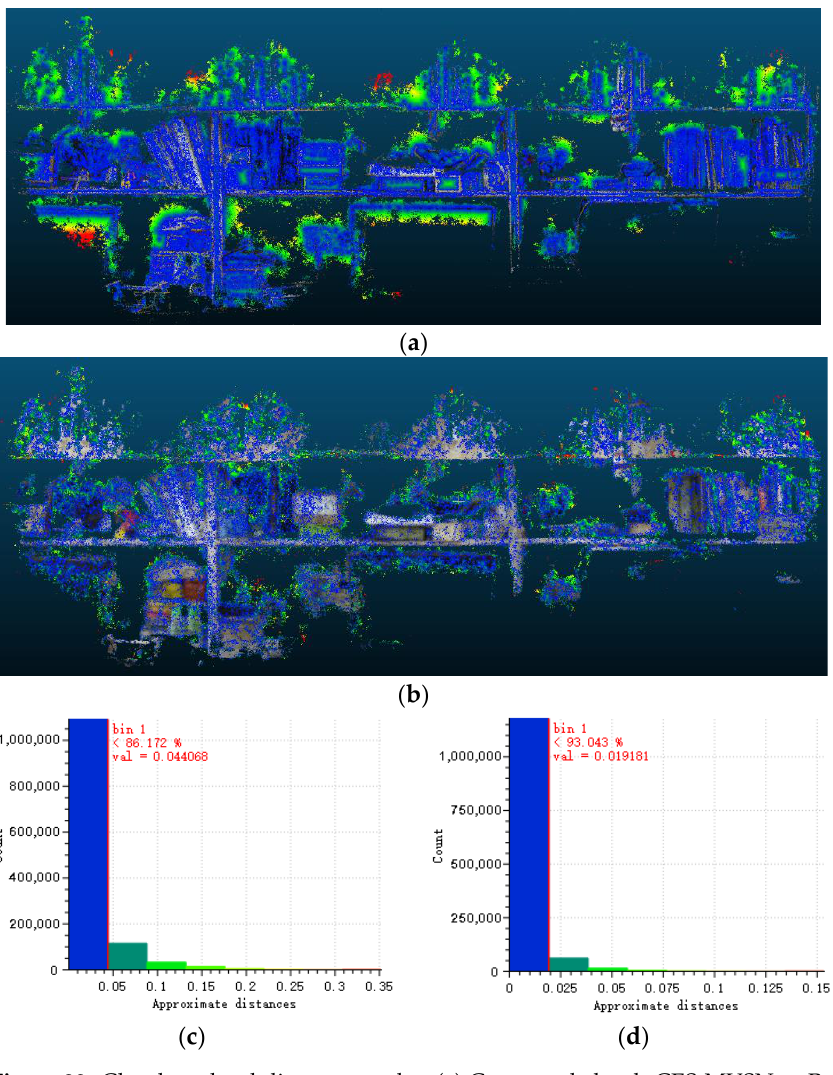
Figure 20. Cloud-to-cloud distance results. ( a ) Compared cloud: CES-MVSNet. Reference cloud: traditional method; ( b ) compared cloud: CES-MVSNet. Reference cloud: MVSNet; ( c ) histogram of the compared cloud in ( a ); ( d ) histogram of the compared cloud in ( b ).